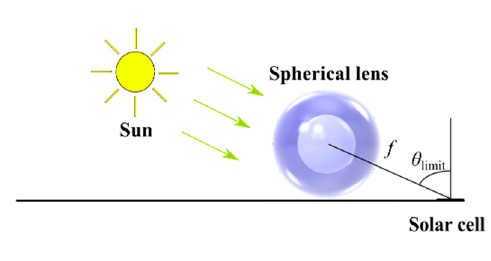
Figure 2. Mechanical angle limit of the microtracking concentrator photovoltaic systems (MTCPV) with a spherical lens.